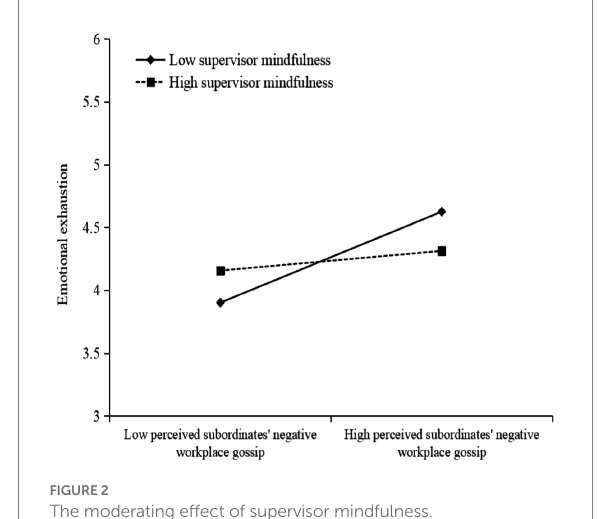
FIGURE 2 The moderating effect of supervisor mindfulness.